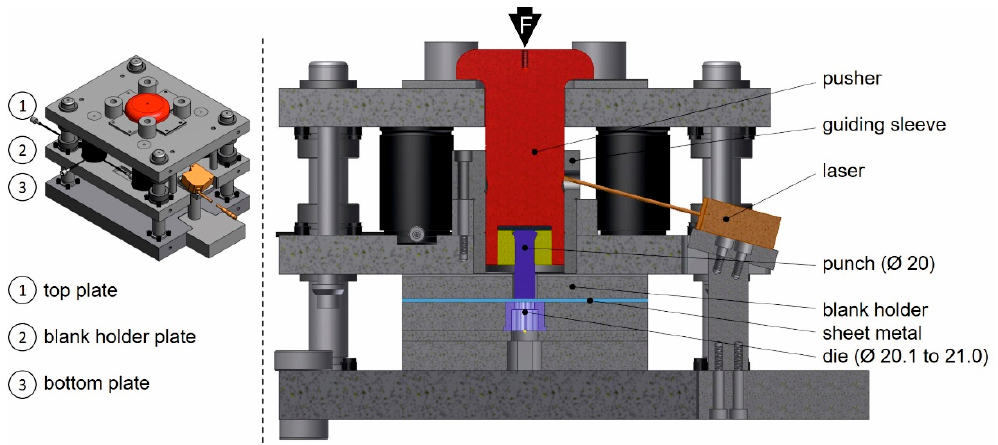
Figure 1. Setup of the tool used for adiabatic blanking. The force is applied to the pusher via a striker unit of the ADIAflex ® machine.